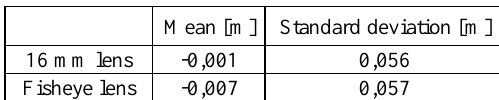
Table 7. Statistical values of set of distances for walls.